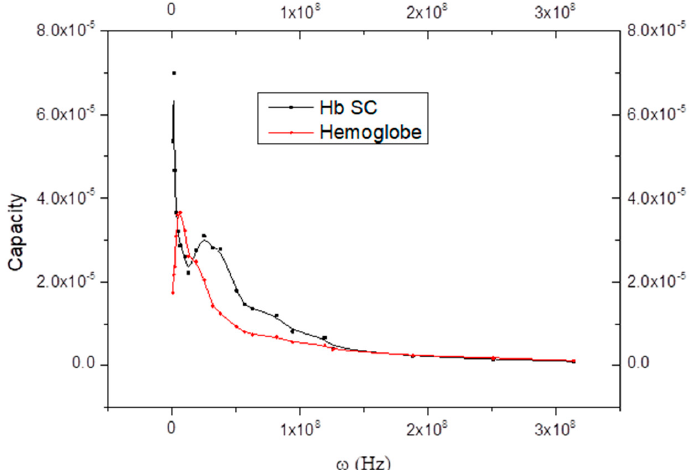
Figure 3. Comparison between HbSC (black line) and Hemoglobe (red line) capacity expressed in p-Farad (pF) calculated by Equations (30) and (31), respectively, as a function of frequency.